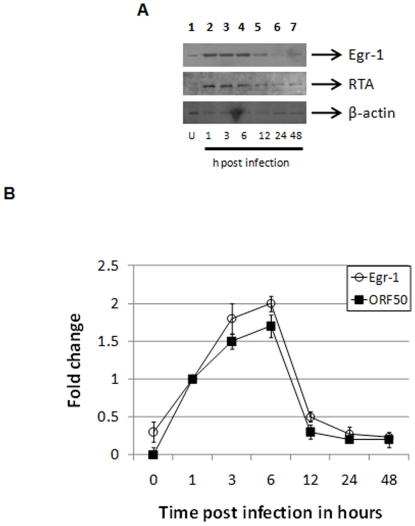
KSHV RTA and Egr-1 follow a similar expression pattern during de novo KSHV infection.HEK293 cells were infected with KSHV at 5 MOI, incubated at 37°C at different time points up to 48 hPI, and lysed. (A) Expression of KSHV RTA and Egr-1 were elevated up to 6 hPI. SDS-PAGE was performed using uninfected (lane 1) or KSHV-infected cell lysates (lanes 2–7). The samples were run on a 10% gel and transferred to a PVDF membrane. Western blotting was performed using specific Egr-1 or KSHV RTA Abs. Abs targeting β-actin were used as internal controls. (B) Analysis of ORF50 and egr-1 transcription. KSHV-infected HEK293 cells were lysed and RNA was extracted. Next, cDNA was synthesized and subjected to quantitative real-time PCR analysis. Baseline expression of genes at 1 hPI was considered as 1-fold for comparisons. Each point denotes the average±S.D. (error bars) of three experiments.